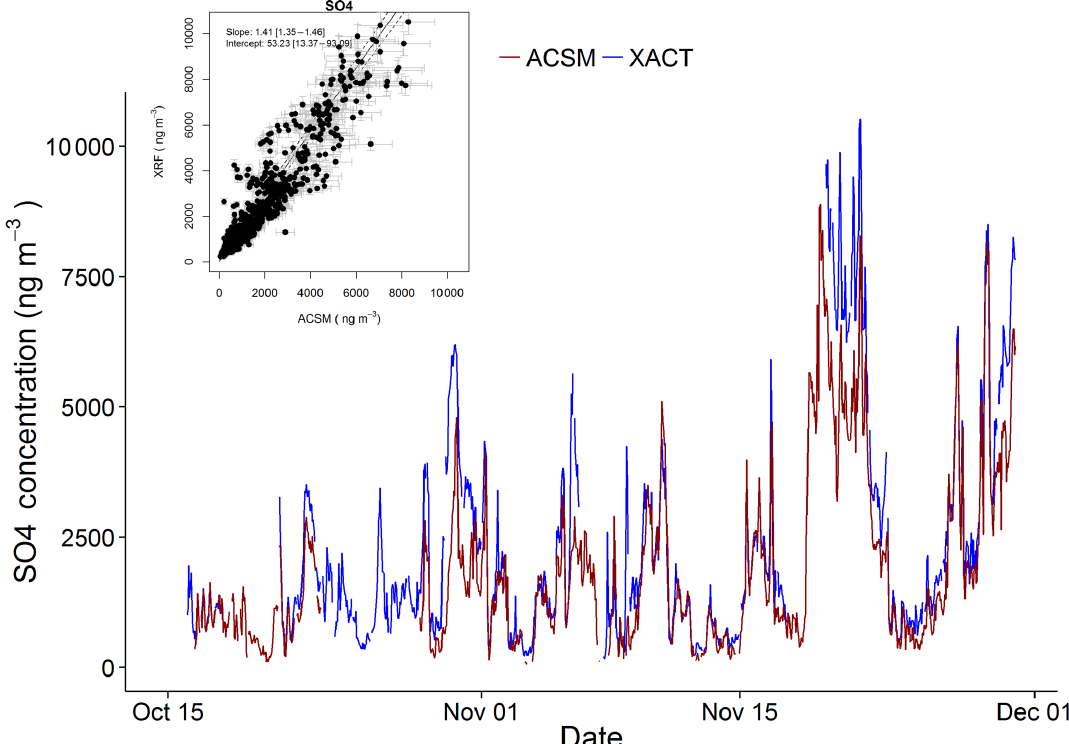
Figure 5. Time series of non-sea salt SO 4 concentration (XACT, calculated) and non-refractory SO 4 (ACSM, measured) in ngm − 3 at Marylebone Road,